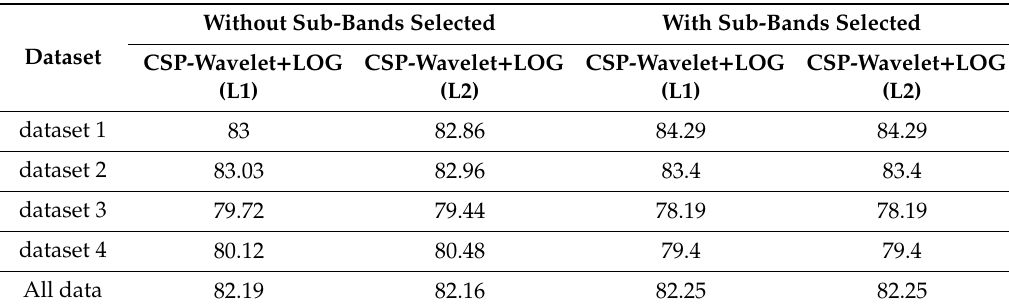
Table 13. The e ff ect of wavelet decomposition layers and sub-band selection on average classification accuracy of various datasets (the CSP-Wavelet method).